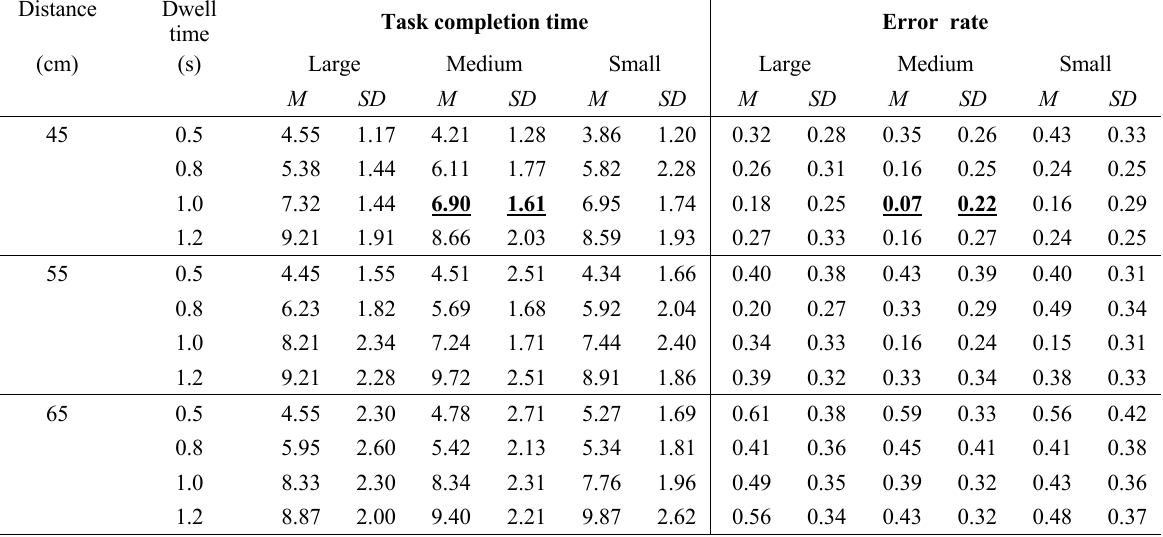
Table 1. Mean and standard deviation for task completion time and error rate across different experimental conditions (user to screen distance; dwell time; central area size).